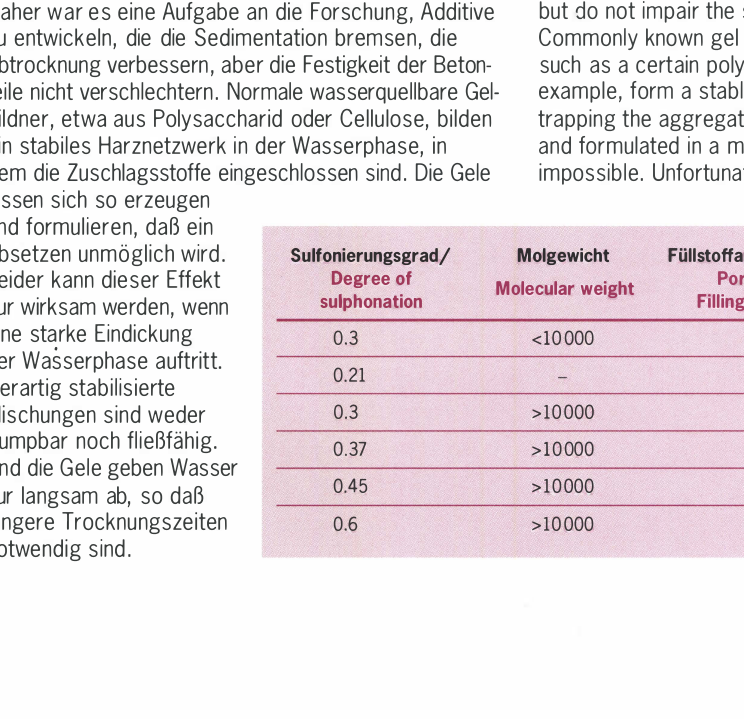
Tab. 1: Ausbreitungsverhalten in Abhangigkeit von Sulfonierungsgrad [2},[3} Table 1: Spreading behaviour depending on the degree of sulphonation